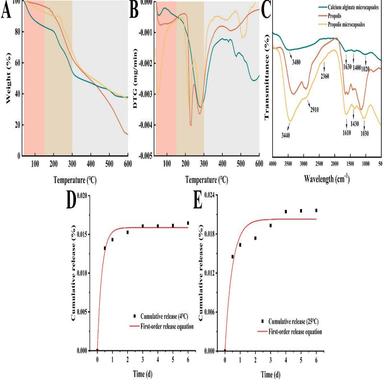
Characterization of PM. (A) and (B) thermogravimetric analysis; (C) FTIR spectroscopy analysis; (D) and (E) the sustained-release effect of PM at 4 ◦C and 25 ◦C respectively. FTIR: Fourier transform infrared.